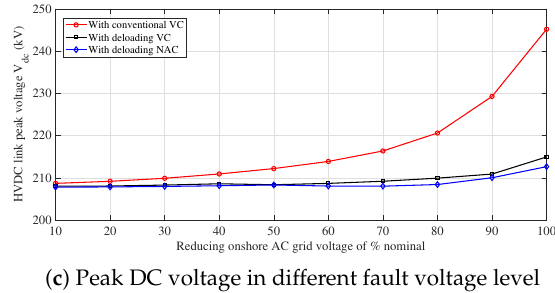
Figure 9. System responses obtained with 0.02 s duration of different reduced voltage levels at onshore AC